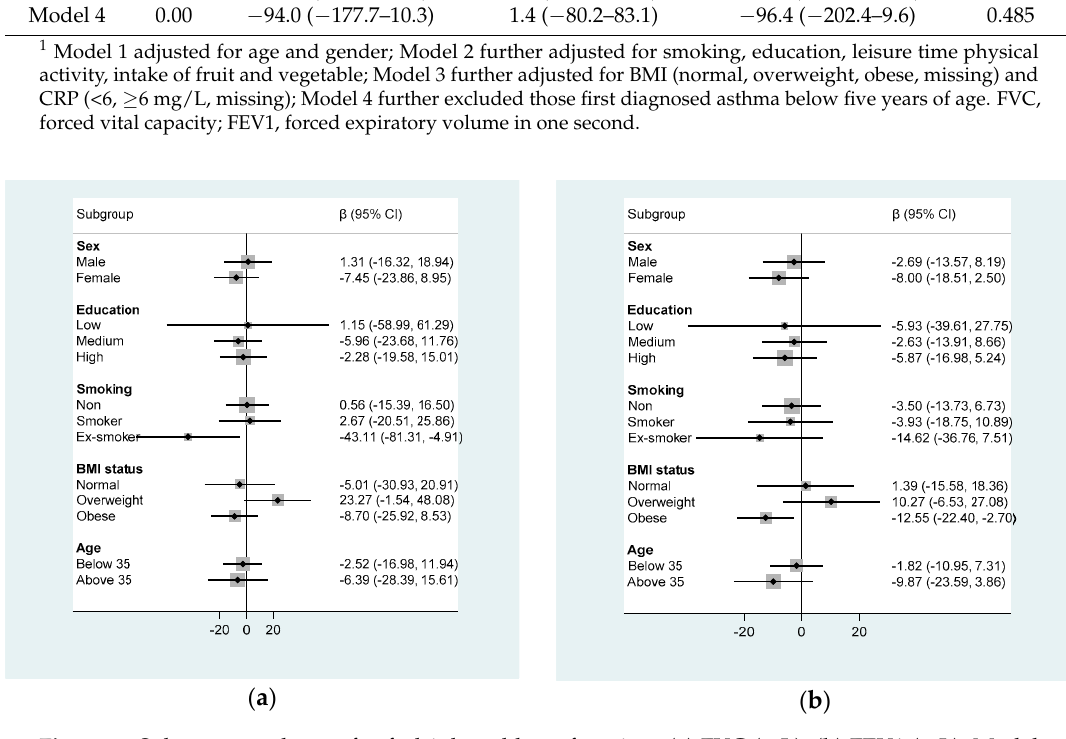
Figure 2. Subgroup analyses of soft drink and lung function. ( a ) FVC (mL); ( b ) FEV1 (mL). Model adjusted for covariates in model 2 of Table 2. Soft drink consumption was used as a continuous variable in the analysis.